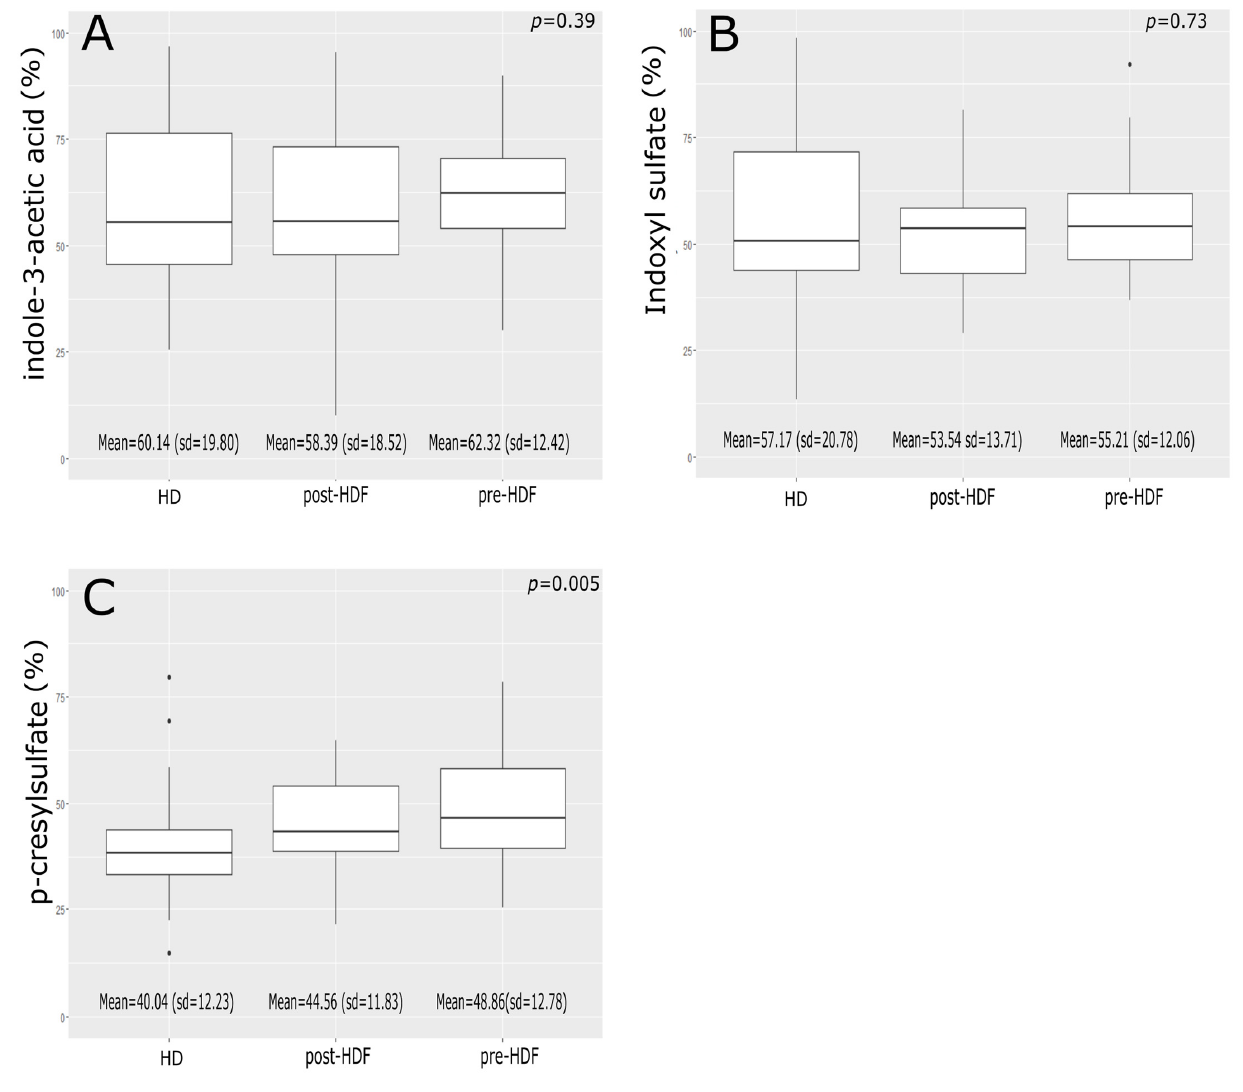
Figure 2. Protein-bound solutes reduction ratio. ( A ) Indole-3-Acetic acid, ( B ) Indoxyl Sulfate, ( C ) p -Cresyl Sulfate. HD: Hemodialysis; HDF: Hemodiafiltration; sd: Standard deviation.